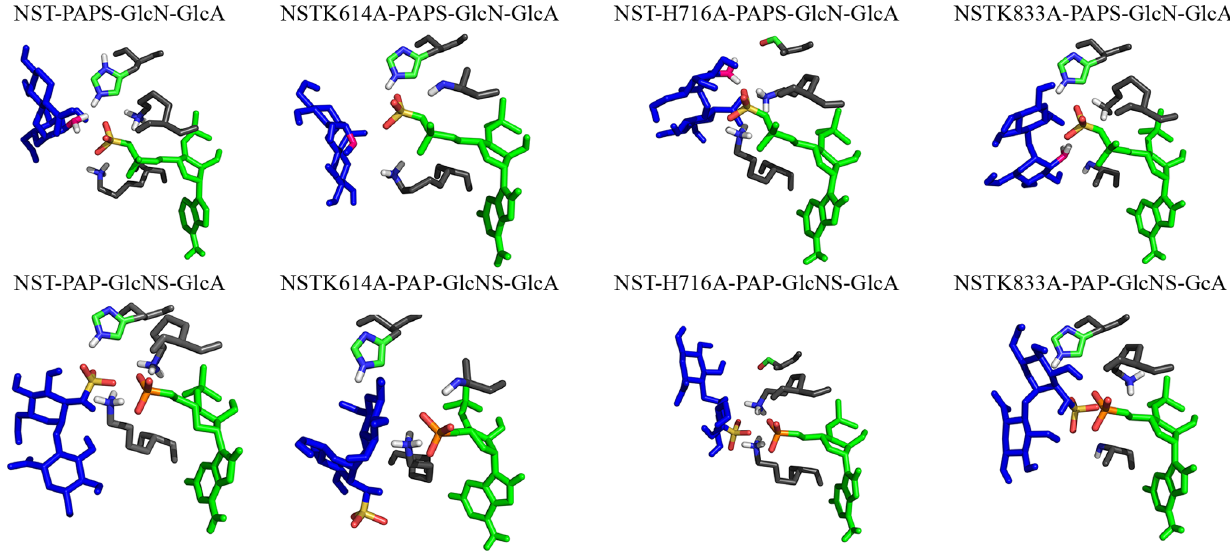
Figure 2. Interactions of N-sulfotransferase domain in NST1 bound to PAPS and PAP with the heparan disaccharide, as predicted by AutoDock. The disaccharide is shown as blue sticks, with sulfate as yellow and amide atoms as pink; PAPS and PAP are shown as green sticks with sulfate as yellow or phosphate as orange. Key reaction residues for enzyme function are shown as gray sticks.